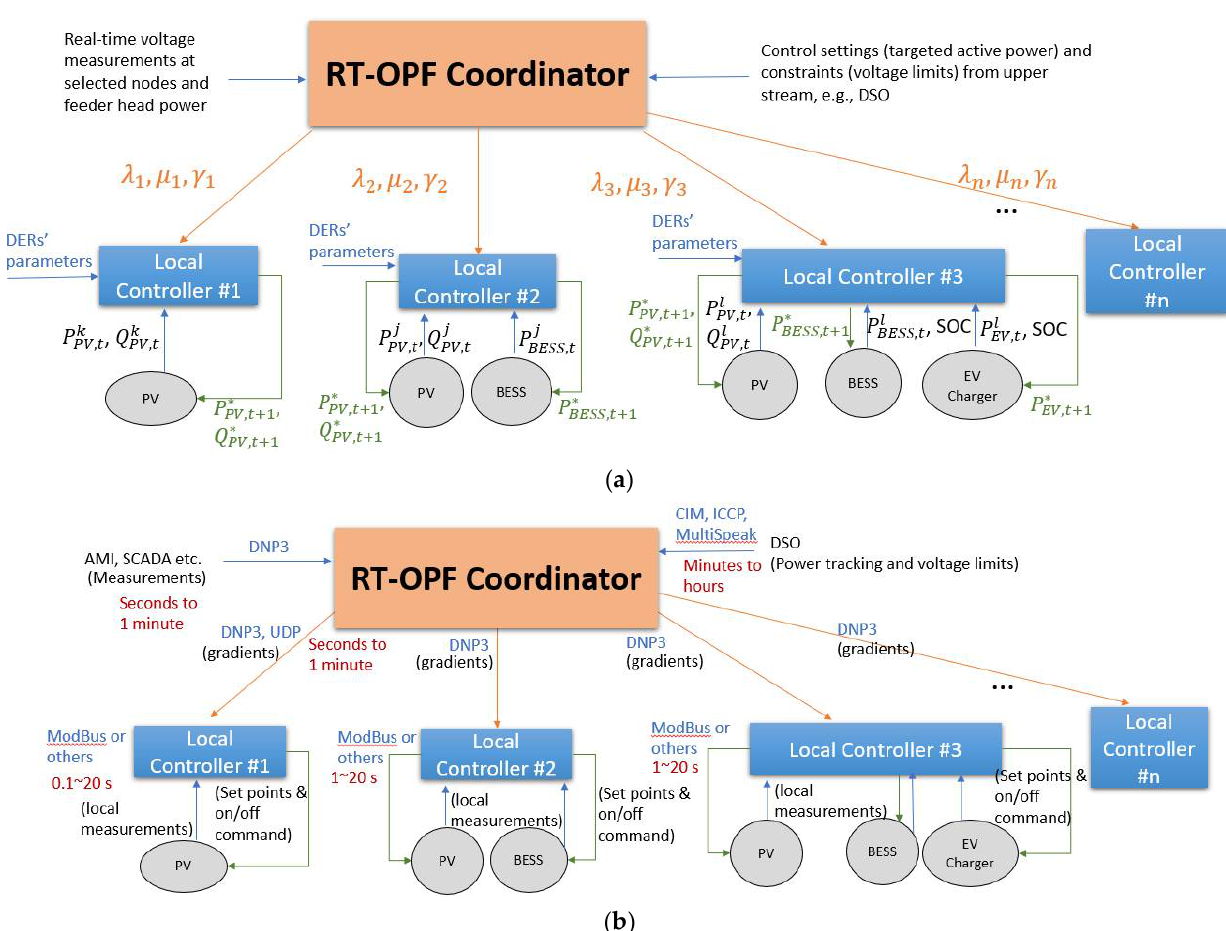
Figure 4. RT-OPF: ( a ) high-level schematics of the DERMS optimization algorithms and ( b ) communication architecture of implementation.